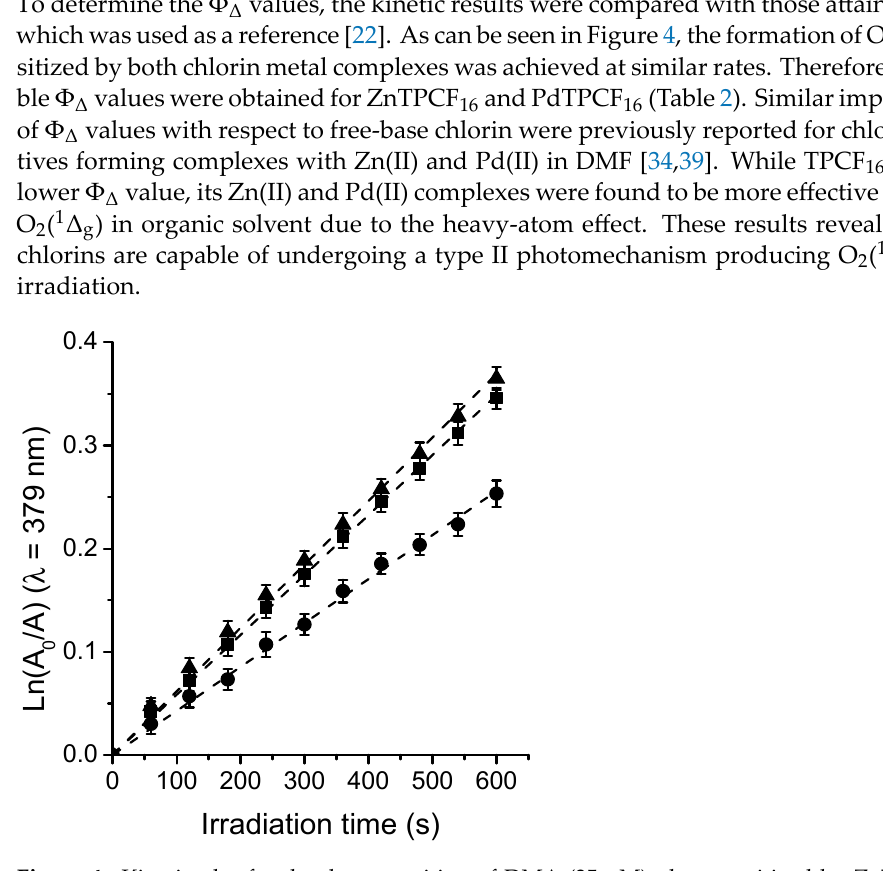
Figure 4. Kinetic plot for the decomposition of DMA (35 µ M) photosensitized by ZnTPCF 16 ( ■ ), Table 2. Photodynamic properties of TPCF 16 , ZnTPCF 16 , and PdTPCF 16 in DMF.